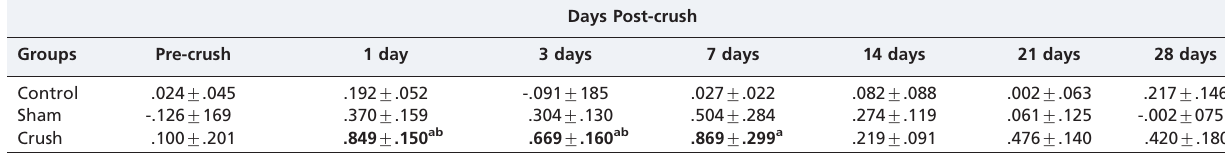
Table 1 - Skin temperature differences ( D T) between the experimental (right) and normal (left) sides at various time points following injury. The D T is shown in ˚